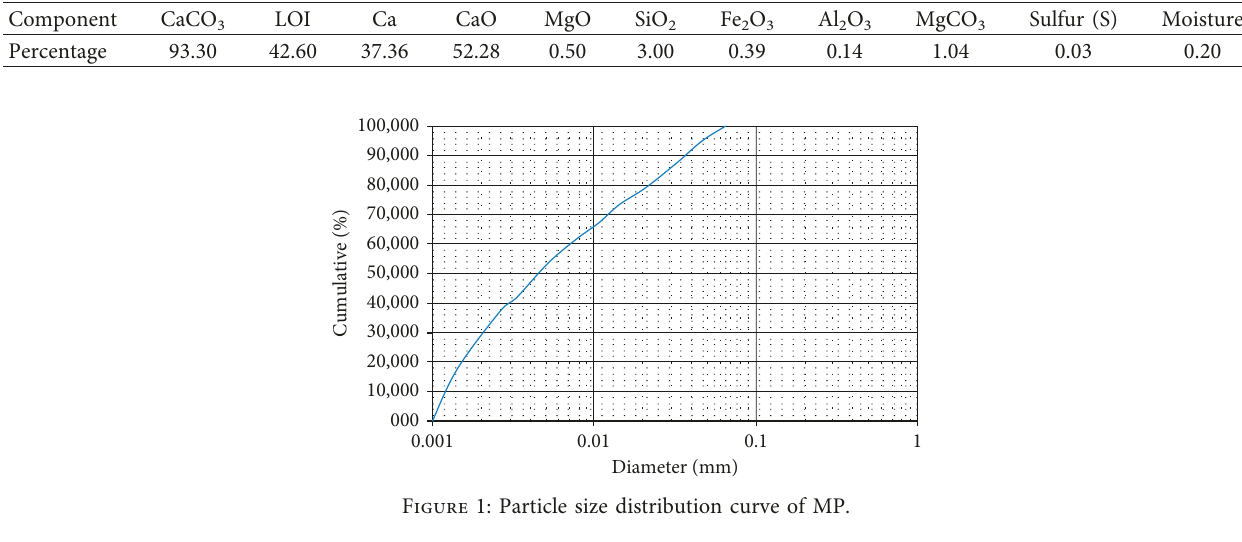
Table 1: Chemical composition of marble powder.